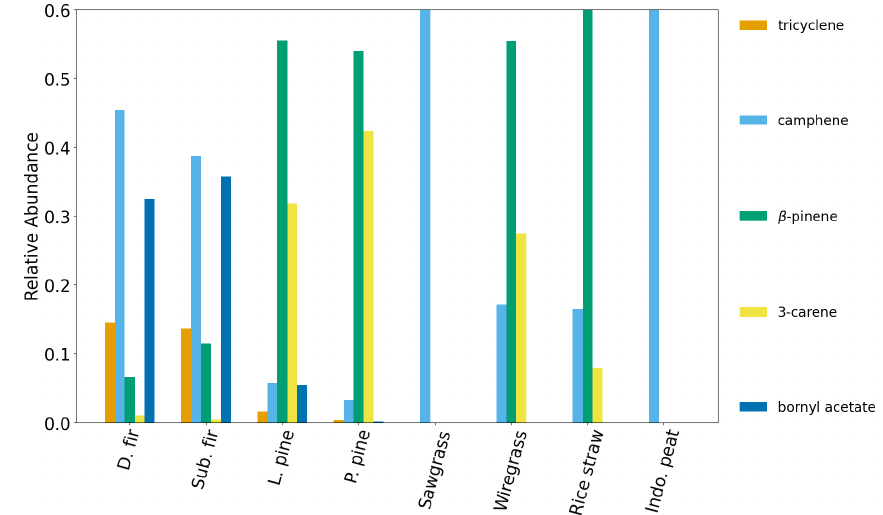
Figure 13. Normalized emission ratio profiles for FIREX FL16 samples (pines and firs) and FLAME-4 FL12 samples (sawgrass, wiregrass, rice straw and Indonesian peat). The relative abundances of camphene and β -pinene in sawgrass, Indonesian peat and rice straw were ≥ 0 . 6, but, for figure clarity, the axis limits were not